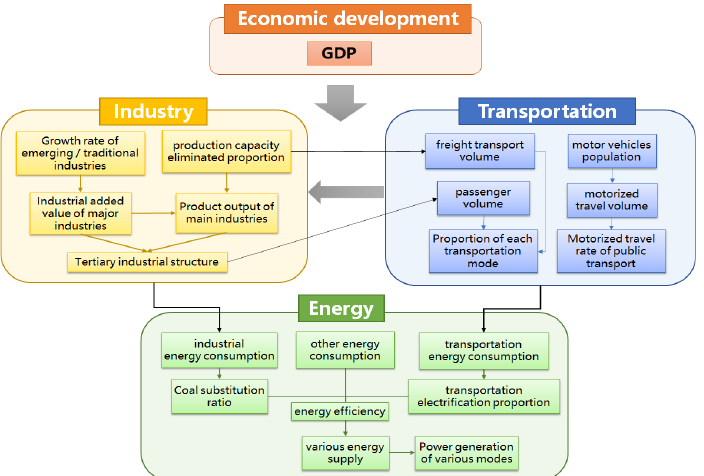
Figure 1. Schematic diagram of construction parameters and constraint relationship of “industry– transportation–energy” linkage development scenario.